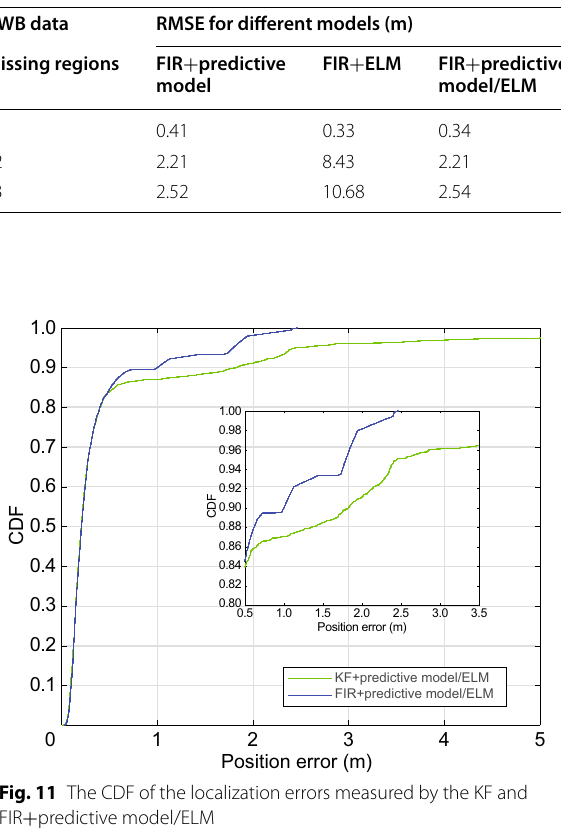
Fig. 11 The CDF of the localization errors measured by the KF and FIR predictive +